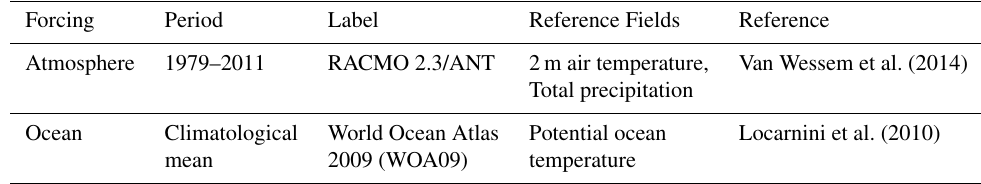
Table 2. Forcing used for ice sheet model spin-up and as reference fields for the anomaly